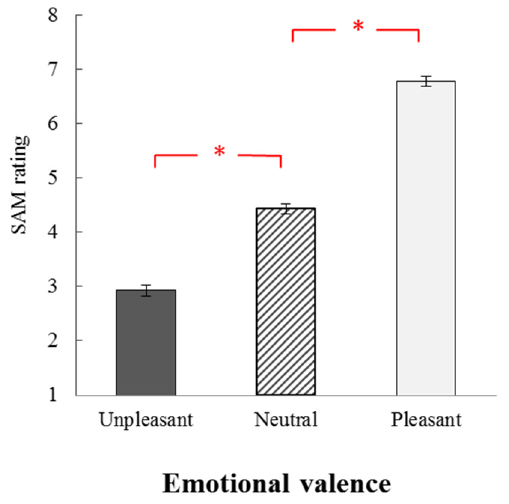
Figure 4. Mean pleasantness ratings for the final collection of stimuli. Pleasantness was rated on a scale of 1 (very unpleasant) to 9 (very pleasant). Error bars represent one standard error of the mean.* = the differences are significant at 0.05 alpha level.